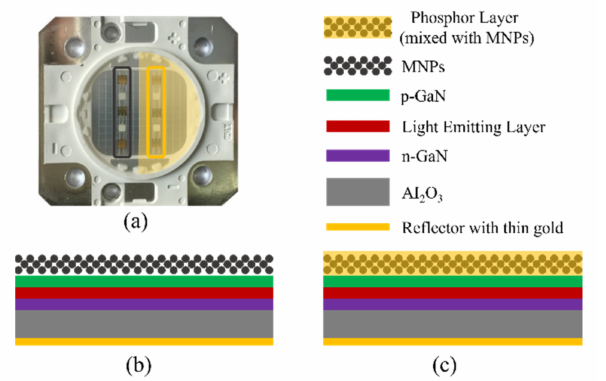
Figure 6. ( a ) Schematic of the multi-chip LED sample, ( b ) with magnetic nanoparticles coated directly on the top surface of LED chip ( c ) with MNPs mixed with the phosphor layer and coated on the LED